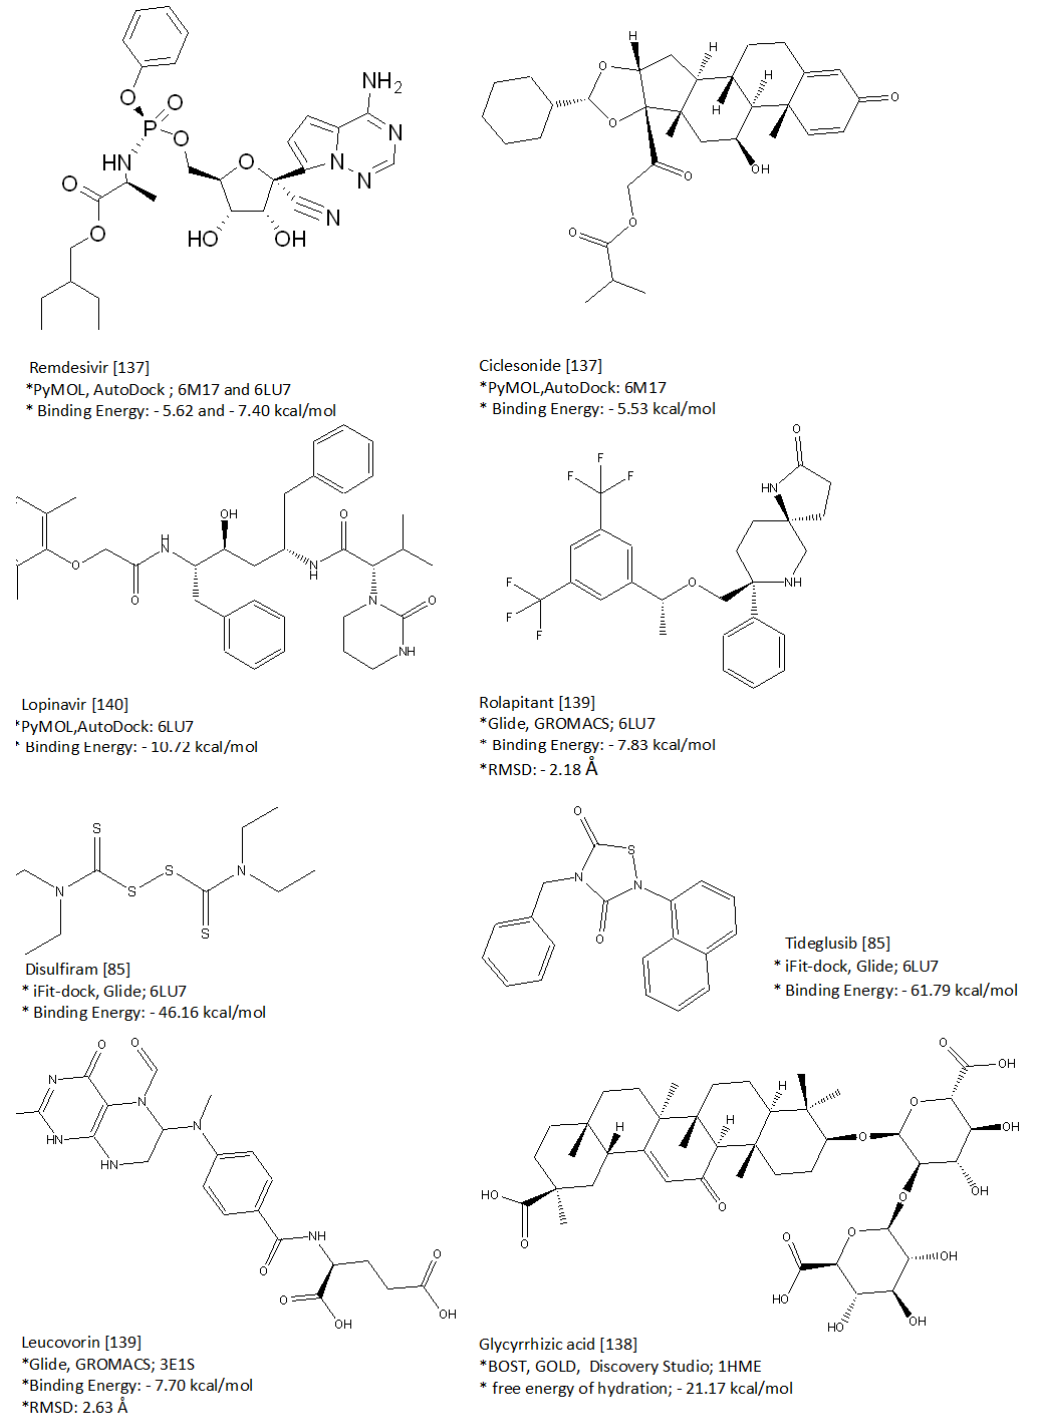
Figure 5. Calculation results of the highlighted potential drugs of SARS-CoV-2.